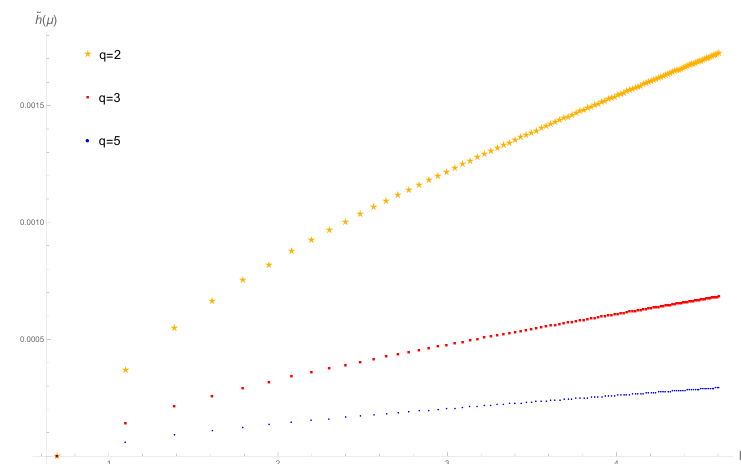
Figure 8. The anomalous dimension of the higher spin operators as a function of the spin of the operators. The yellow stars, red dots and the blue crosses are for q = 2 ; 3 ; 5 respectively and (cid:22)q (cid:0) 1 = (cid:15) = 0 : 01. The horizontal axis is log( s ) where s is the spin of the operator. The vertical axis is the anomalous dimension. It is observed that when s is relatively large, the anomalous dimension is propotional to the log of the spin. This is the same behavior as the result from a perturbative higher-spin CFT computation [136], as well as the dispersion relation of a classical rotating string in AdS spacetime in the large-spin limit